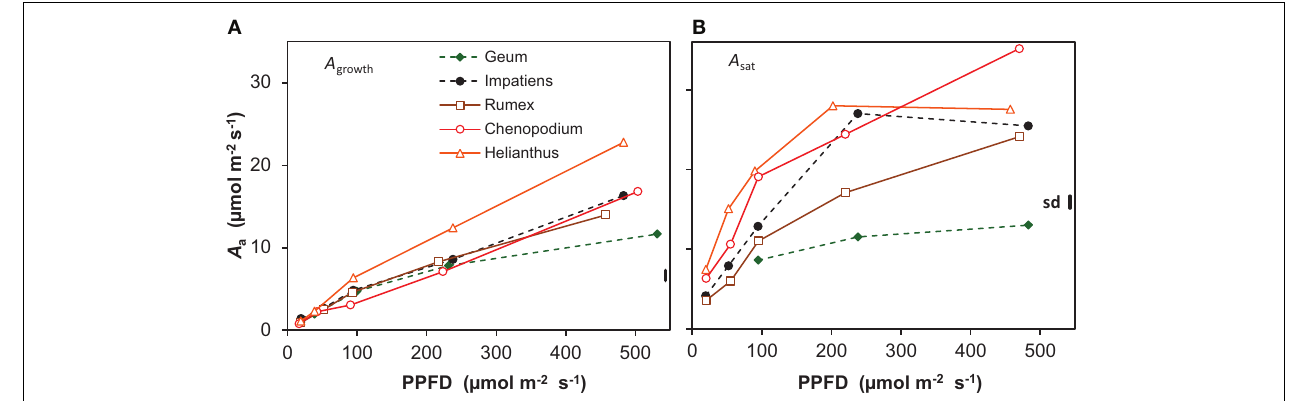
of photosynthesis per unit leaf area ( A sat ) measured on recently matured leaves. Means ( n = 8 and n = 3 for A growth and A sat , respectively) and the common standard deviation (sd) are shown.